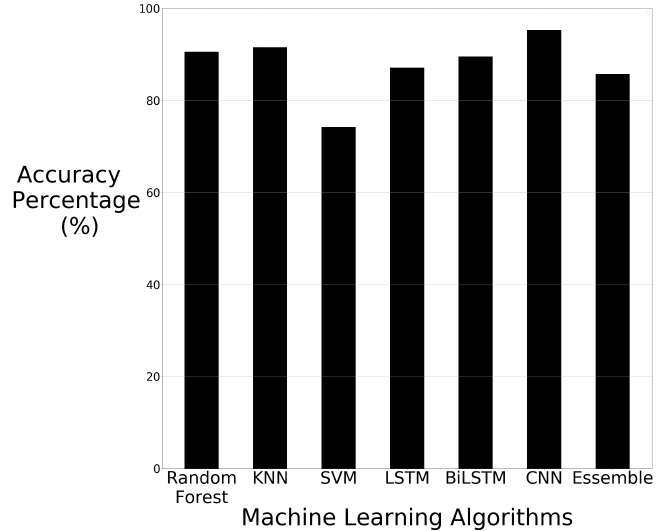
Figure 9. Machine learning results using data augmentation with